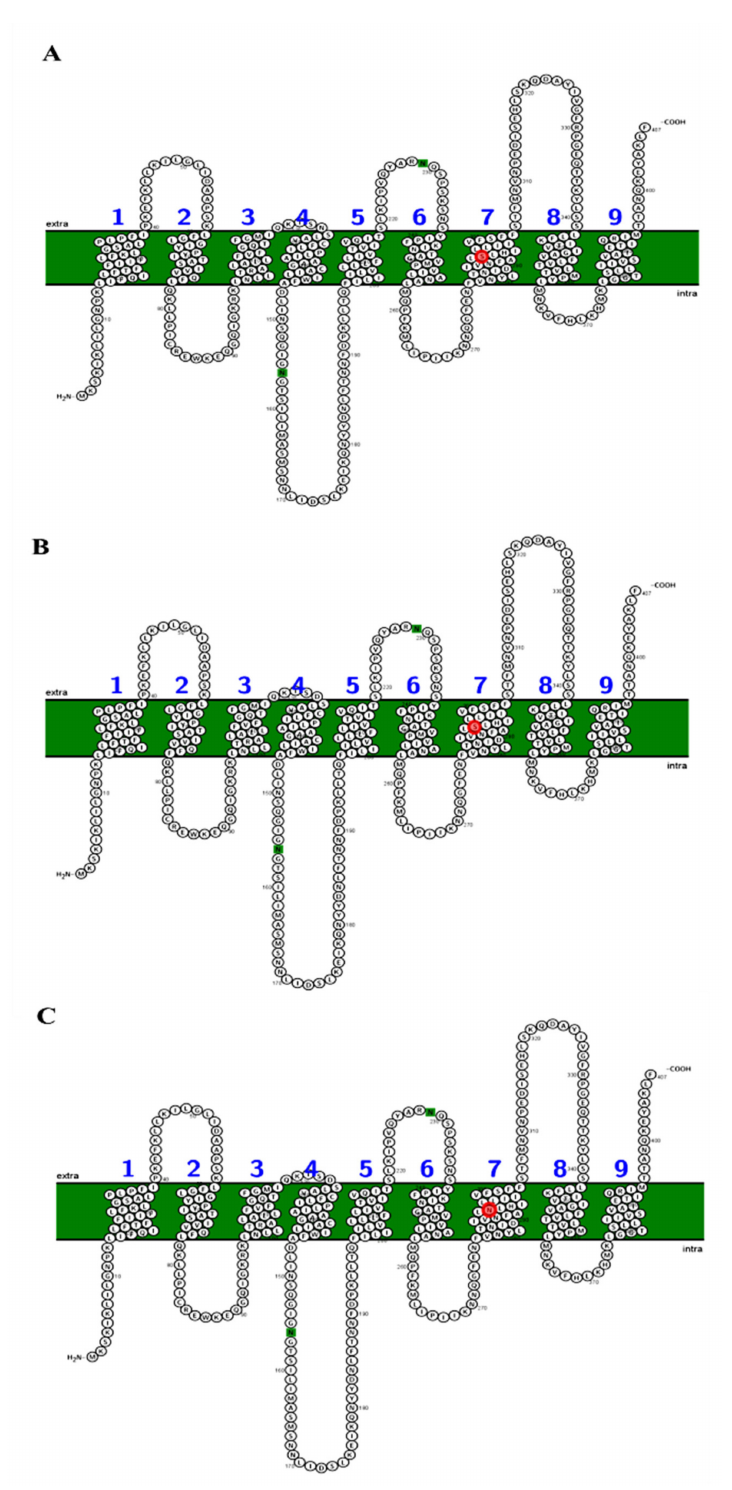
Figure 5. Schematic representation of the organization of the SecY6 ( A ), SecY33 ( B ), and SecY52 ( C ) variant structures consisting of 10 transmembrane domains. The single amino acid substitution in transmembrane region 7 region the position 292 is marked in red. Each amino acid is abbreviated by its first-letter code, green circle indicates signal